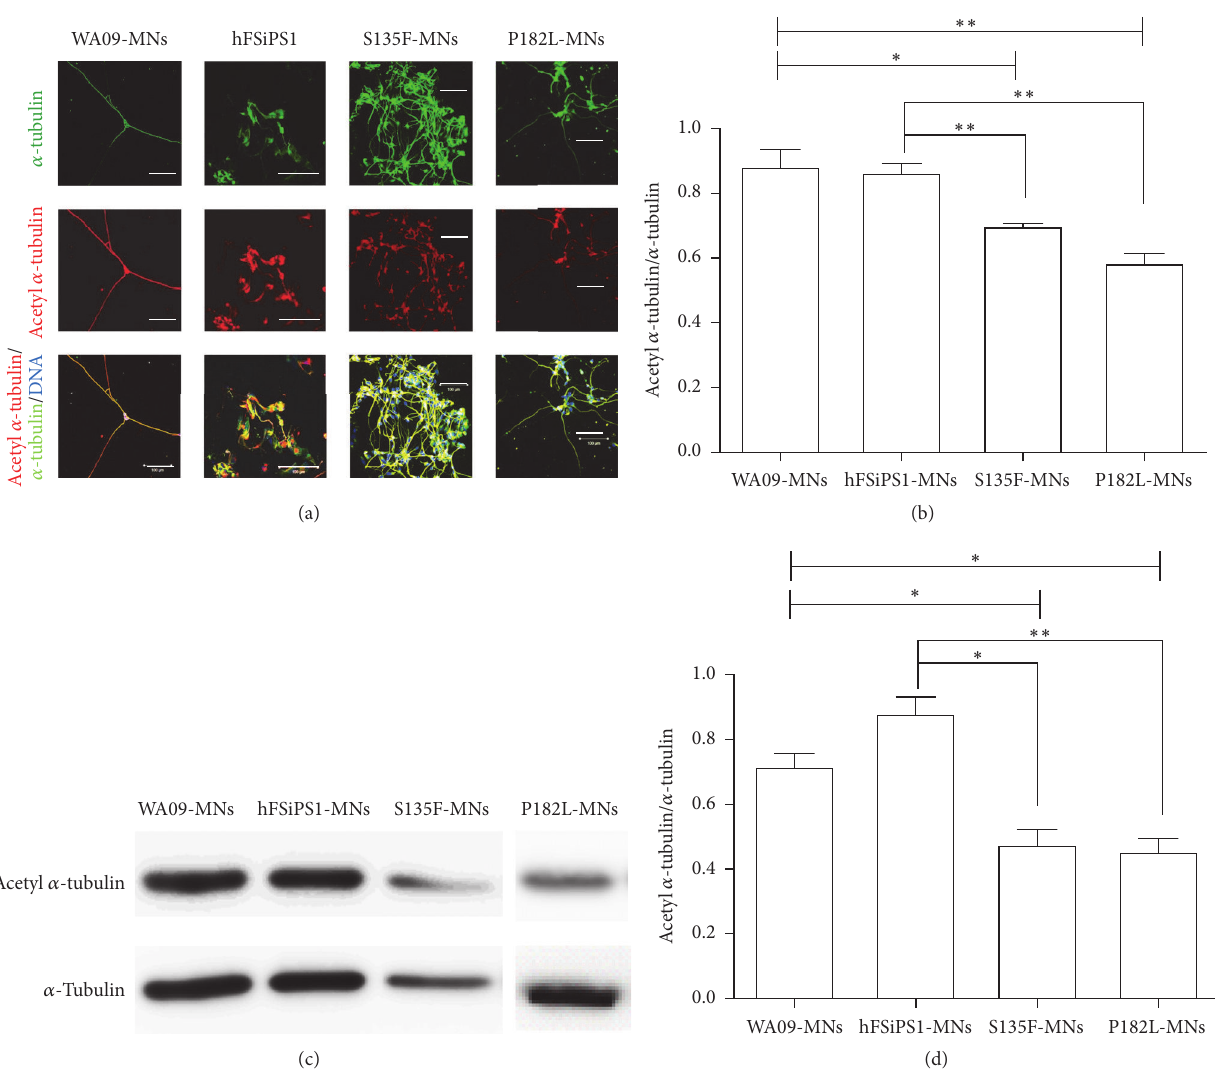
Figure4:Reducedacetylationof 𝛼 -tubulininS135F-MNsandP182-MNs.(a)Acetylationof 𝛼 -tubulinwasvisualizedbyimmunostainingwith anti-acetylated 𝛼 -tubulin Abs (red). Total 𝛼 -tubulin was also detected by staining with anti- 𝛼 -tubulin Abs (green) (original magnification, 400x). Scale bars: 100 𝜇 m. (b) The extent of acetylated 𝛼 -tubulin was normalized with corresponding total 𝛼 -tubulin using ImageJ software (WA09-MNs; 𝑁 = 3 , S135F-MNs; 𝑁 = 4 , and P182L-MNs; 𝑁 = 5 ). Unpaired 𝑡 -tests, ∗ 𝑃 < 0.05 and ∗∗ 𝑃 < 0.01 . (c and d) Western blot